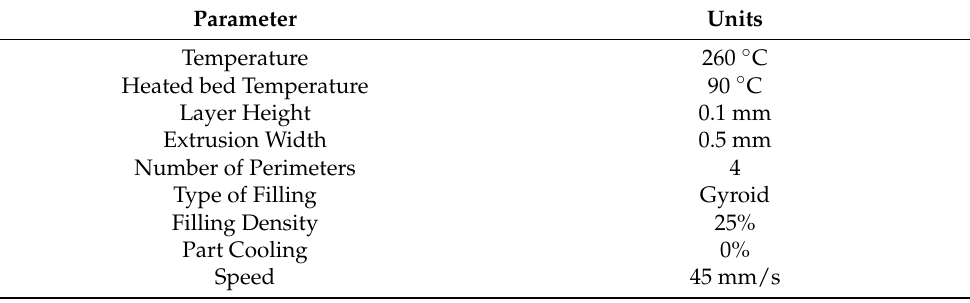
Table 2. Three-dimensional printing parameters used for printing with the PETG-CF.